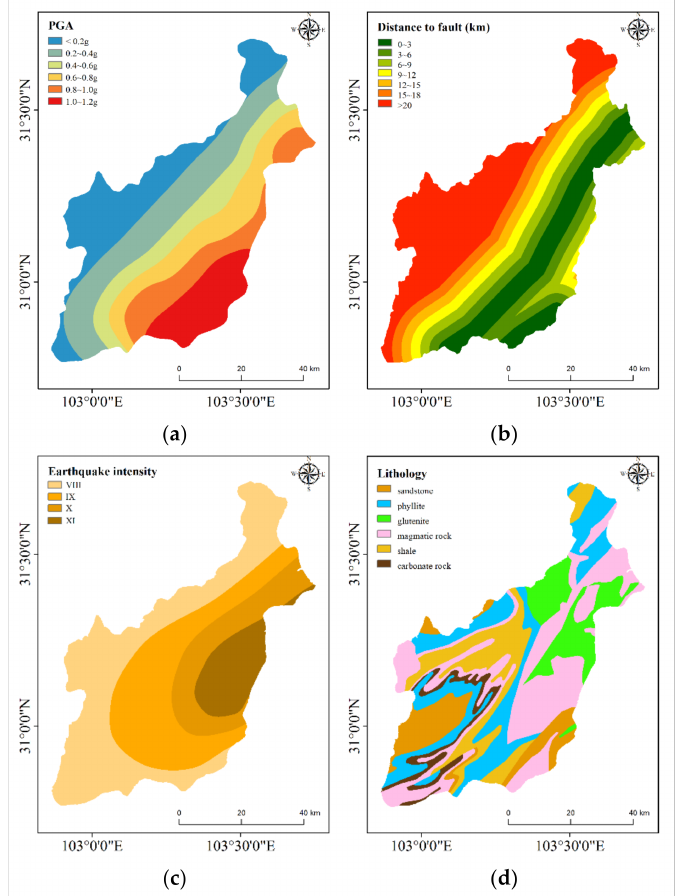
Figure 3. Seismology-related causative factors. ( a ) PGA; ( b ) Distance of fault; ( c ) Earthquake intensity; ( d )